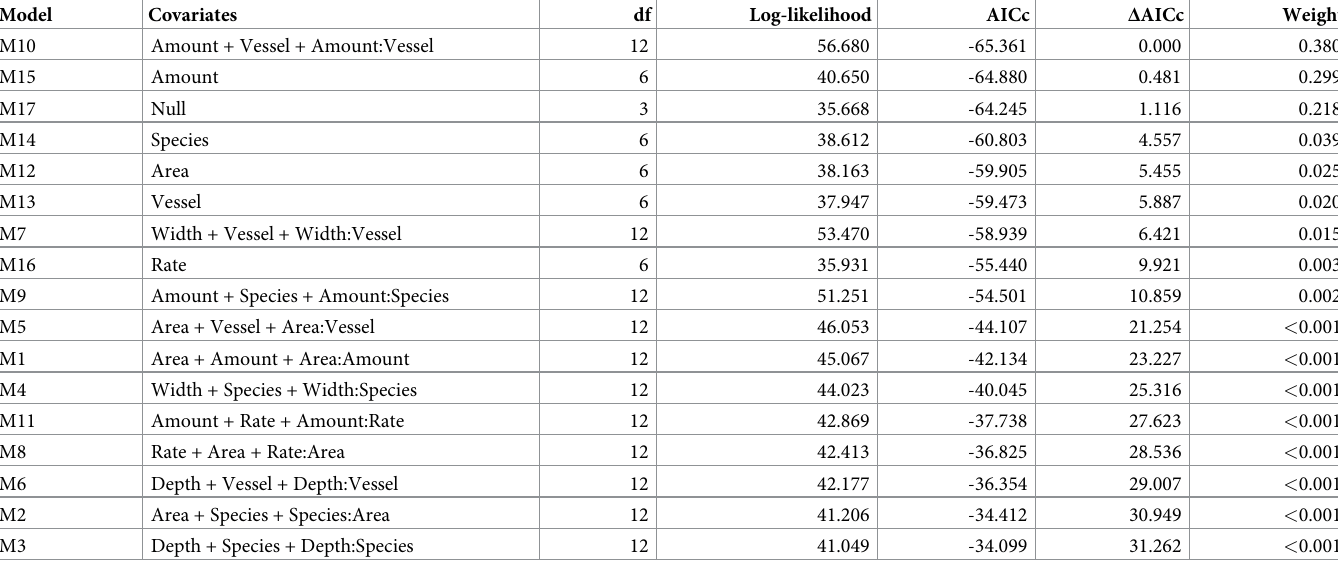
Table 4. Dirichlet model ranking. Ranking of candidate Dirichlet regression models to explain the behavioural composition of fish whilst slipping from purse seines. Model Covariates df